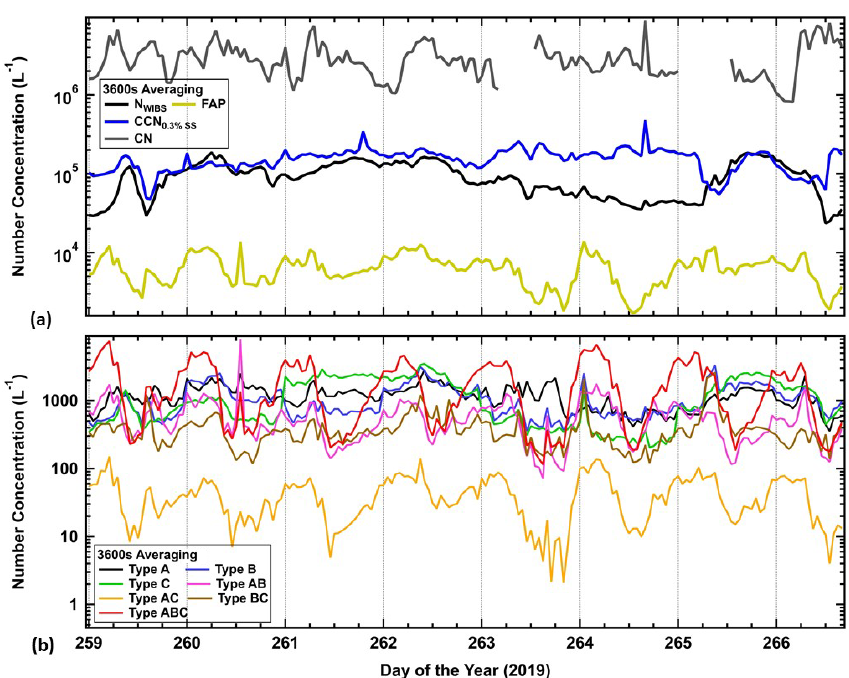
Figure 2. Time series of the number concentrations of (a) CN, CCN, N WIBS and FAPs as well as of (b) FAP types A, B, C, AB, AC, BC and ABC. The gaps in time in the CN concentrations were when the CPC was offline.